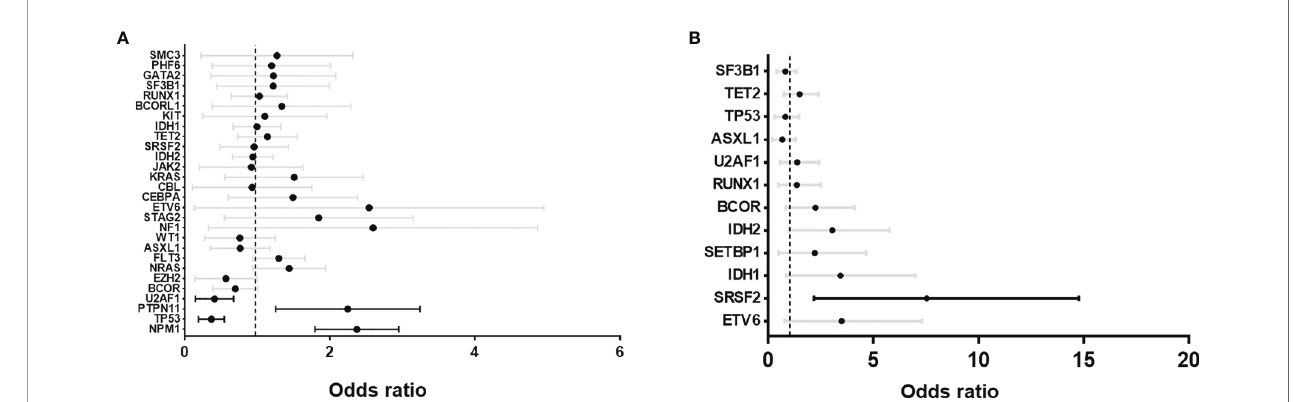
FIGURE 2 | Forrest plots of odds ratio with 95% con fi dence internal of co-existing mutations between DNMT3A R882 vs. non-R882 mutant cases. (A) Acute myeloid leukemia (AML) and (B) myelodysplastic syndrome (MDS). GENIE database and myeloid studies available in cBioPortal were extracted and used for the analysis. Statistically signi fi cant co-existing mutation are highlighted with black lines.